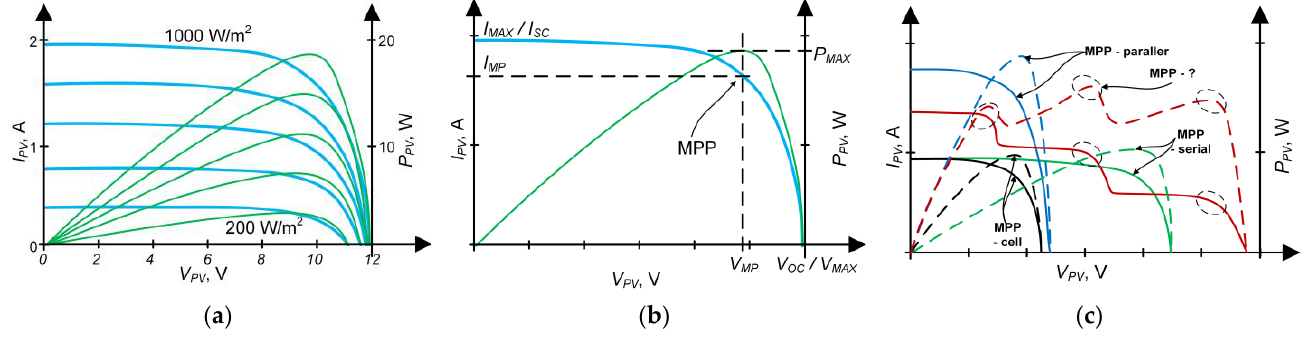
Figure 1. PV module operation parameters: ( a ) examples of I - V and P - V characteristics of PV module for lighting intensity from 200 W/m 2 to 1000 W/m 2 , in steps of 200 W/m 2 ; ( b ) basic operating parameters of the PV module, V MP , I MP —voltage and current of MPP at given solar luminance conditions, V OC —voltage of open circuit, I SC —current of short circuit; ( c ) changes in I - V and P - V characteristics in connection systems of PV cells: solid line—current, dot line—power, black—one cell, blue—parallel connection of two cells, green—serial connection of two cells, red—hypothetical curves of PV net configuration under environmental disturbances